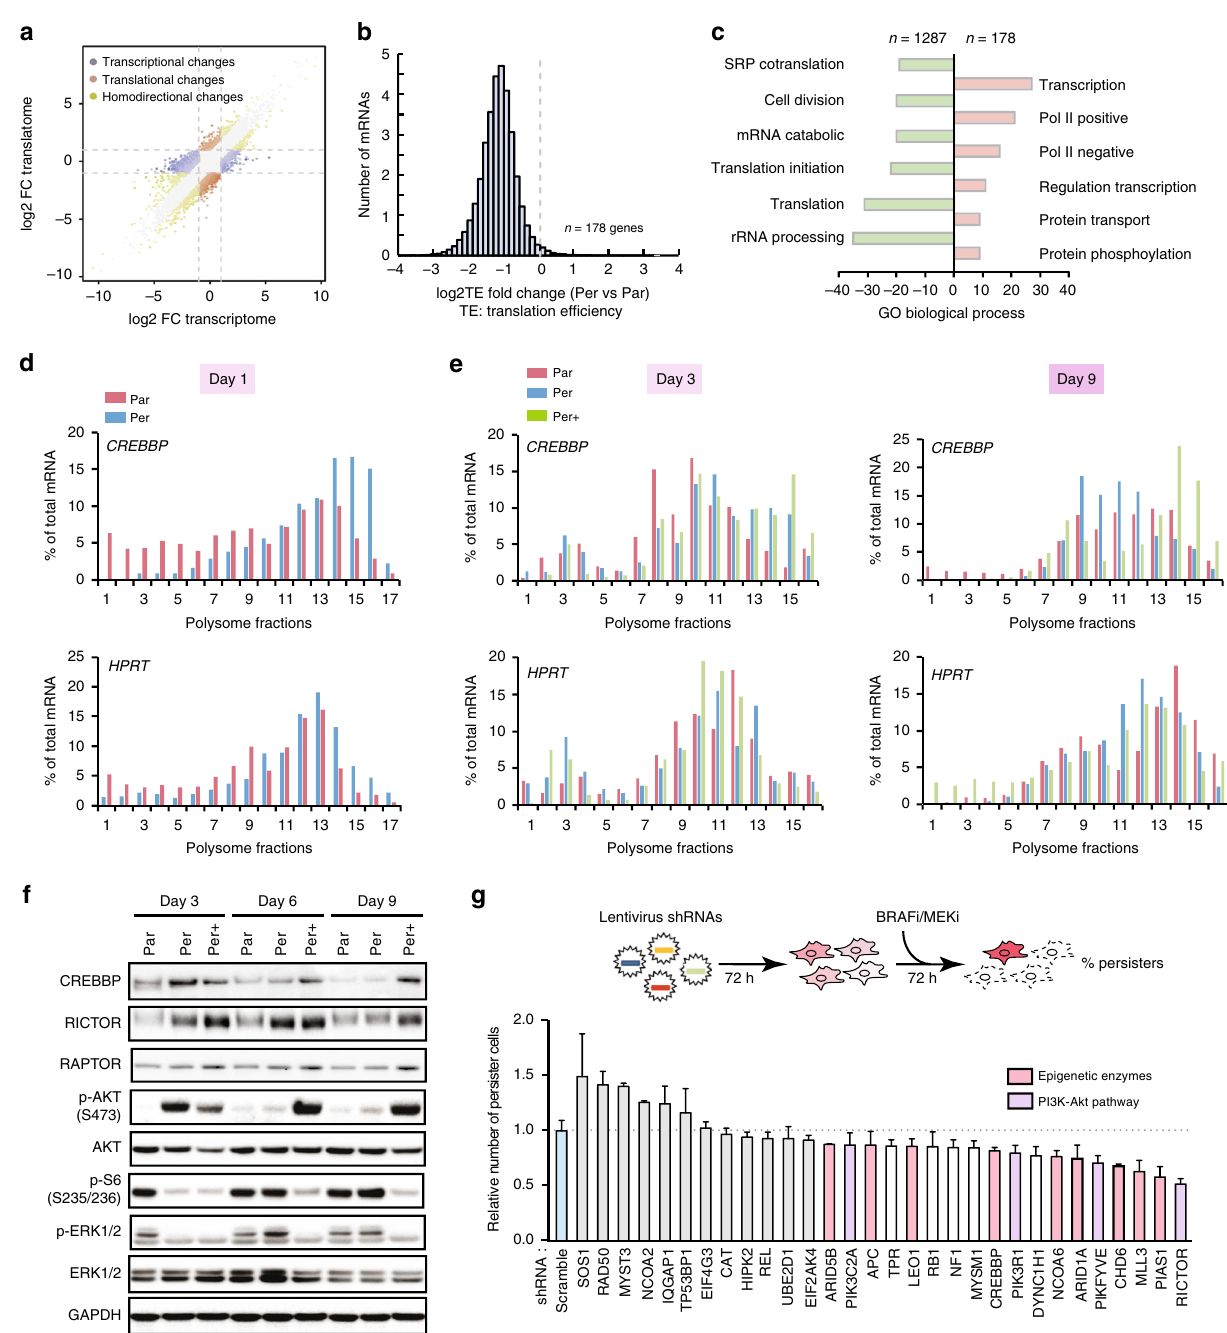
Fig. 2 Dynamic translation remodelling drives melanoma persistence. a Transcriptional and translational analysis of genome-wide polysome pro fi le between persister and parental cells. Colour-coded are genes with the adjusted P -value < 0.05 with fold change >2 (DESeq2); n = 3 per group for both polysome pro fi ling and exon-array. One hundred and seventy-eight transcripts showed upregulation at the translational level. b Differential translational ef fi ciency (TE = Expression polysome mRNA /Expression total mRNA ) of persister vs. parental cells. c David gene ontology (GO) analysis of mRNAs regulated at the translational level (red: upregulation; green: downregulation) in persister vs. parental cells. d , e RT-qPCR quanti fi cation of CREBBP mRNA (top panel) or HPRT mRNA (bottom panel) in fractions (horizontal axes) obtained by sucrose-gradient ultracentrifugation of lysates from persister versus parental cells from day 1 ( d ), day 3 and 9 ( e ) following BRAFi/MEKi withdrawal. Par: parental cell; Per: persister cell cultured in drug-free medium; Per + : persister cell cultured in BRAFi/MEKi containing medium. f Protein level and related pathway activity analysis by western blotting at various time points. S: serine. g Lentivirus-based shRNA screening for persister cell survival. A375 cells were transduced with pLKO.1 lentivirus shRNAs for 3 days and then were treated with lethal concentrations of BRAFi/MEKi (both at 1 μ M) for 3 days. Percentage of survival persister cells was evaluated by WST-1-based cell viability assay, data were normalized to the percentage of persister cells from scramble shRNA-transduced cells. The raw data of d , e , g and f are available in Source